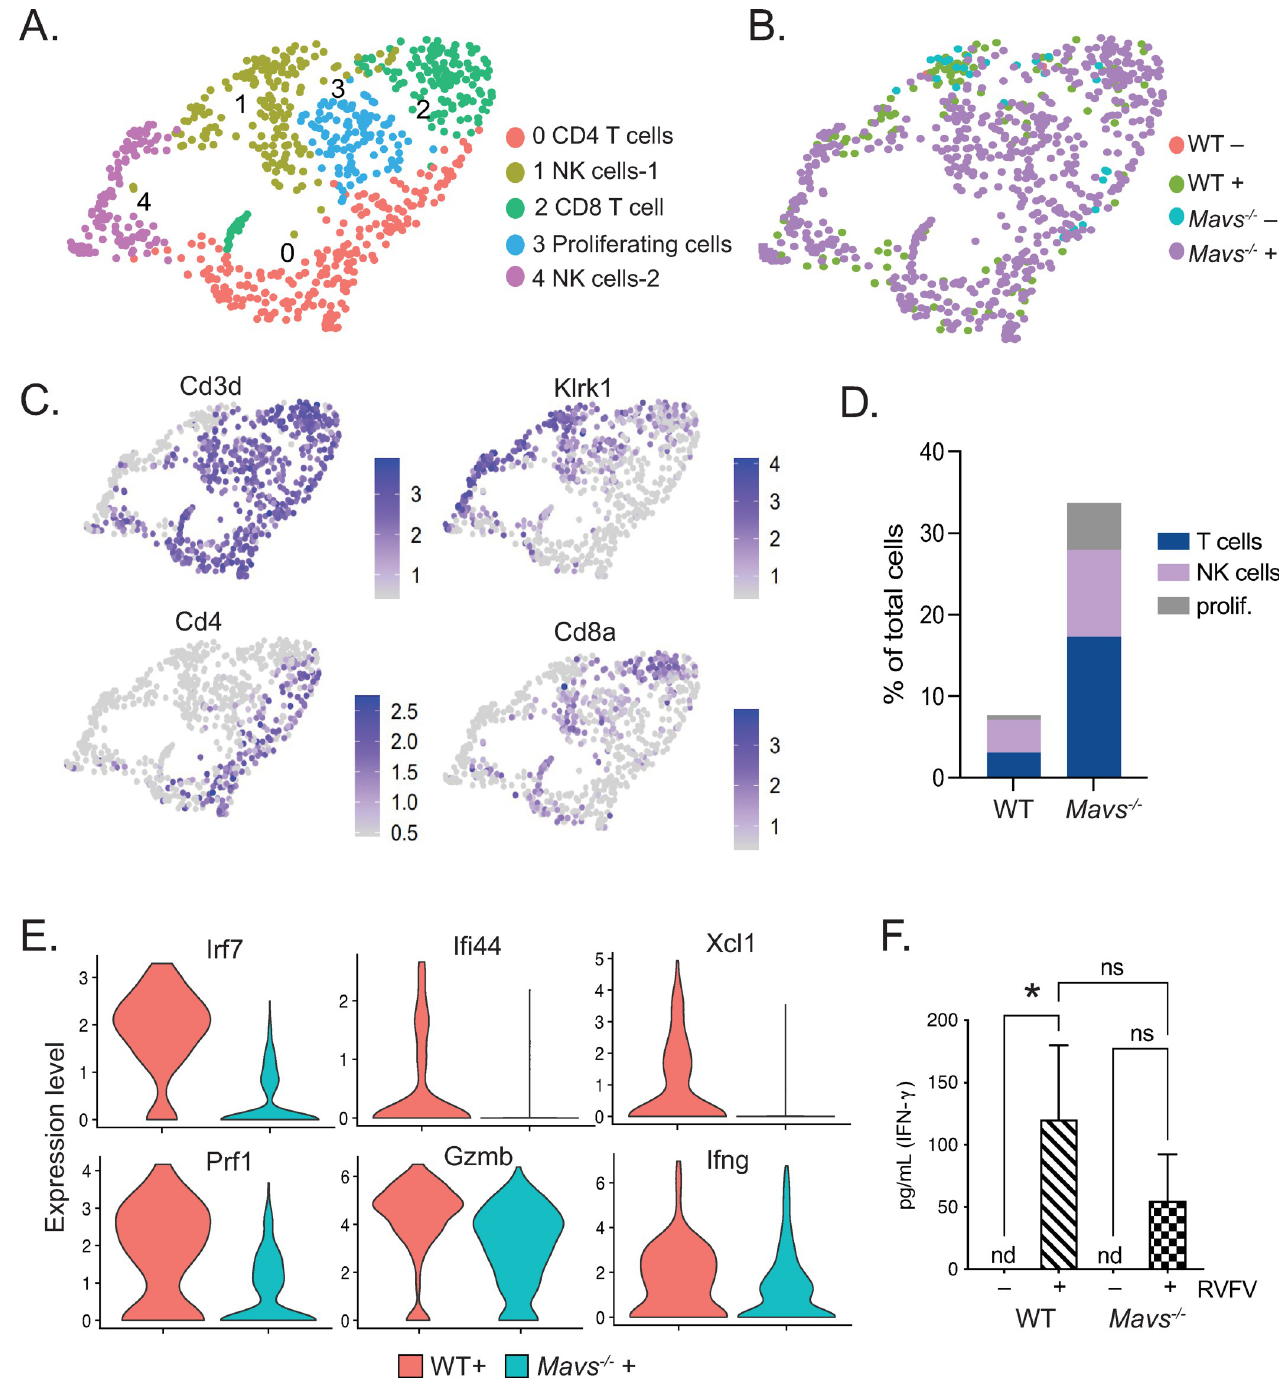
Fig 7. Dysregulated pattern of lymphocyte infiltration and gene expression in brains of Mavs -/- mice. UMAP plots depicting cell clusters of lymphoid lineage cells derived from WT and Mavs -/- brains, +/- RVFV infection. Cell types (A) or conditions (B) are color coded. Feature plots showing expression of cell type specific markers are shown in (C). The distribution of lymphoid lineage cell types within brains of infected mice (D). Violin plots depicting the relative expression of selected genes within all lymphocytes are shown in (E). Quantitation of IFN- γ is depicted in (F). � p < 0.05.